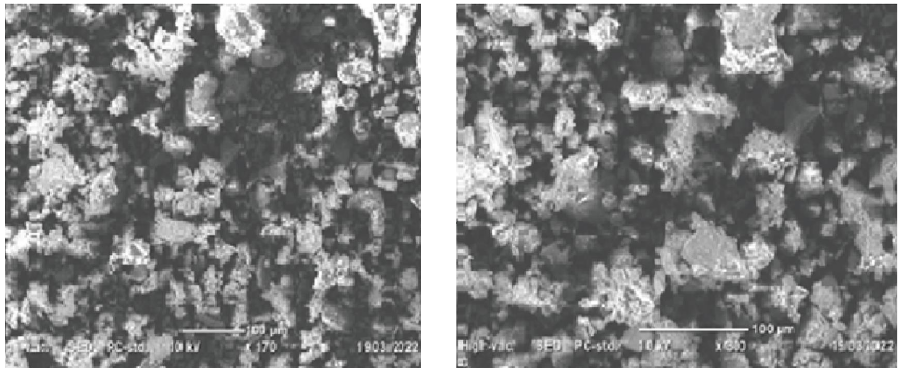
Figure 9: SEM image for the KH product at x170 and x300 resolution.